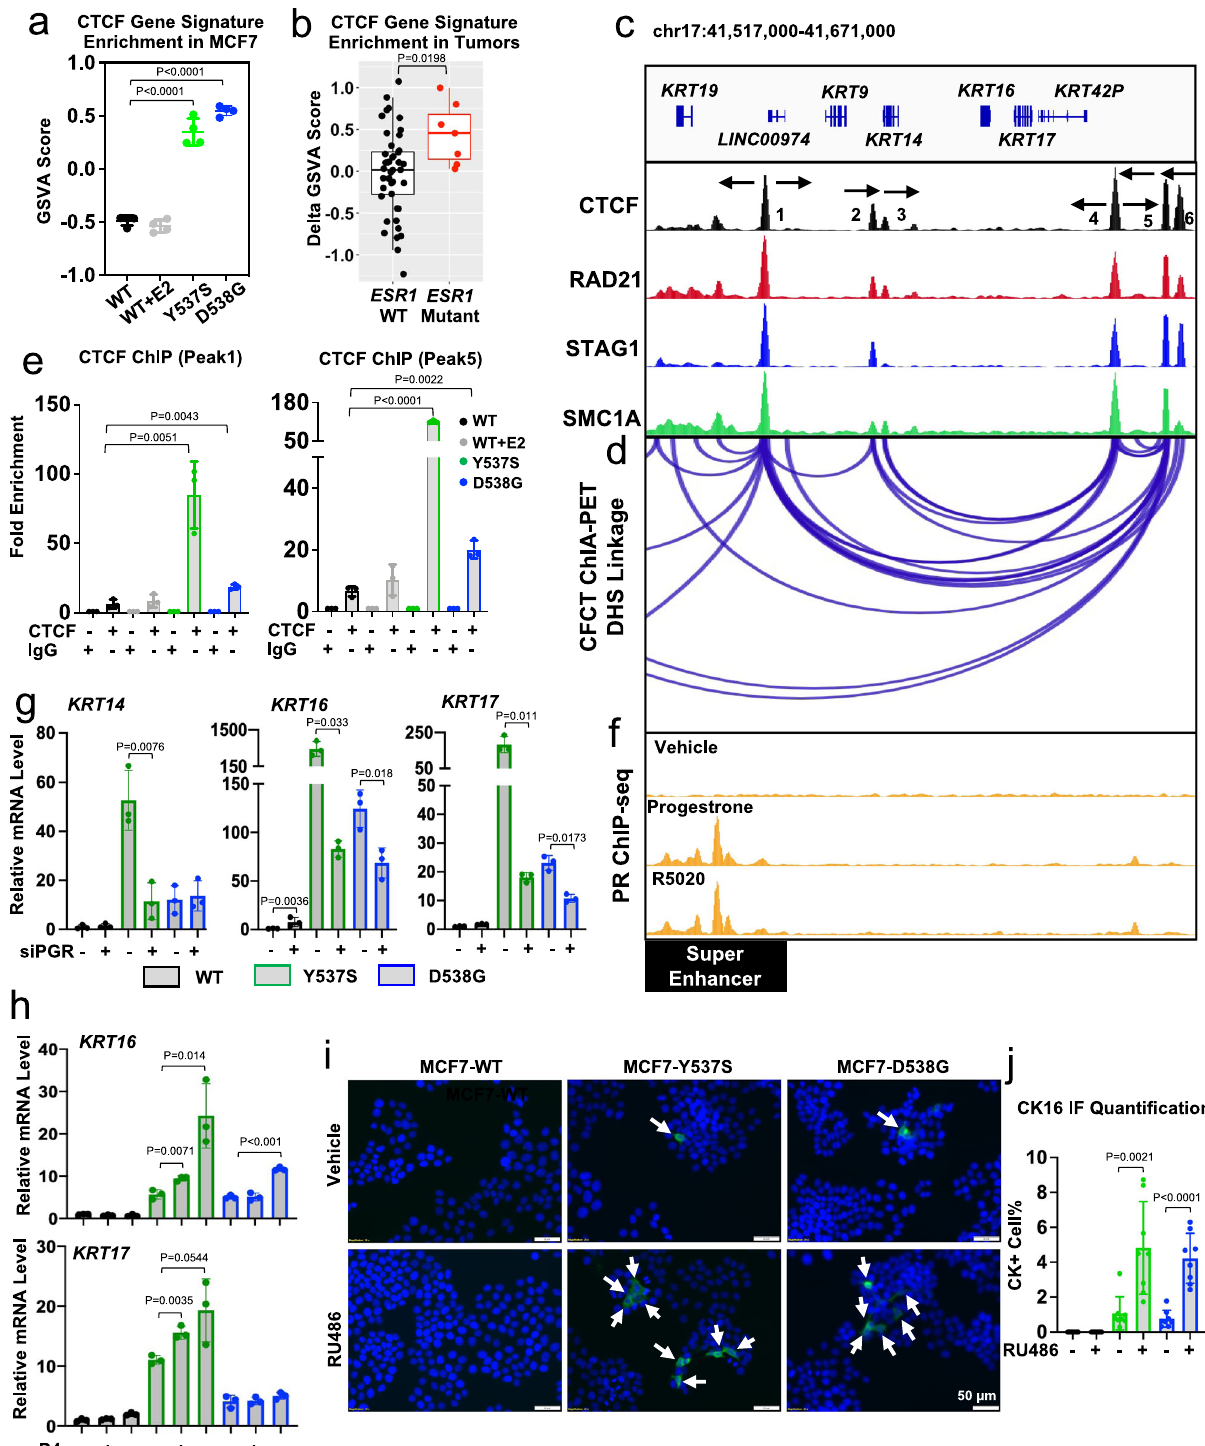
concentrations in plasma from patients with ESR1 mutations (Fig. 6d). S100A8-A9 heterodimer mainly stimulates downstream cas- cades through two receptors: toll-like receptor 4 (TLR4) and receptor for advanced glycation end products (RAGE), and both of them are widely reported to impact cancer immunity. A further gene set variation analysis in WCRC/DFCI primary-matched paired metastatic samples revealed consistent enrichment of